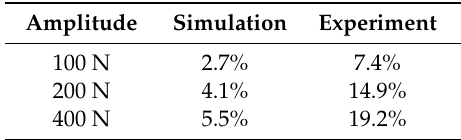
Table 4. Amplitude attenuation with damping force load. Table 3. Phase advance with spring force load.